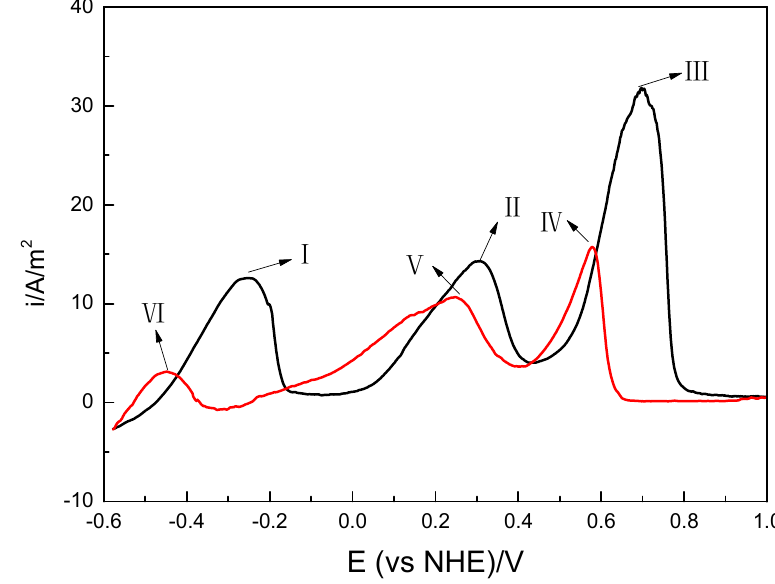
Figure 2. Cyclic Voltammetry plot of gold electrode in conventional cyanide system.